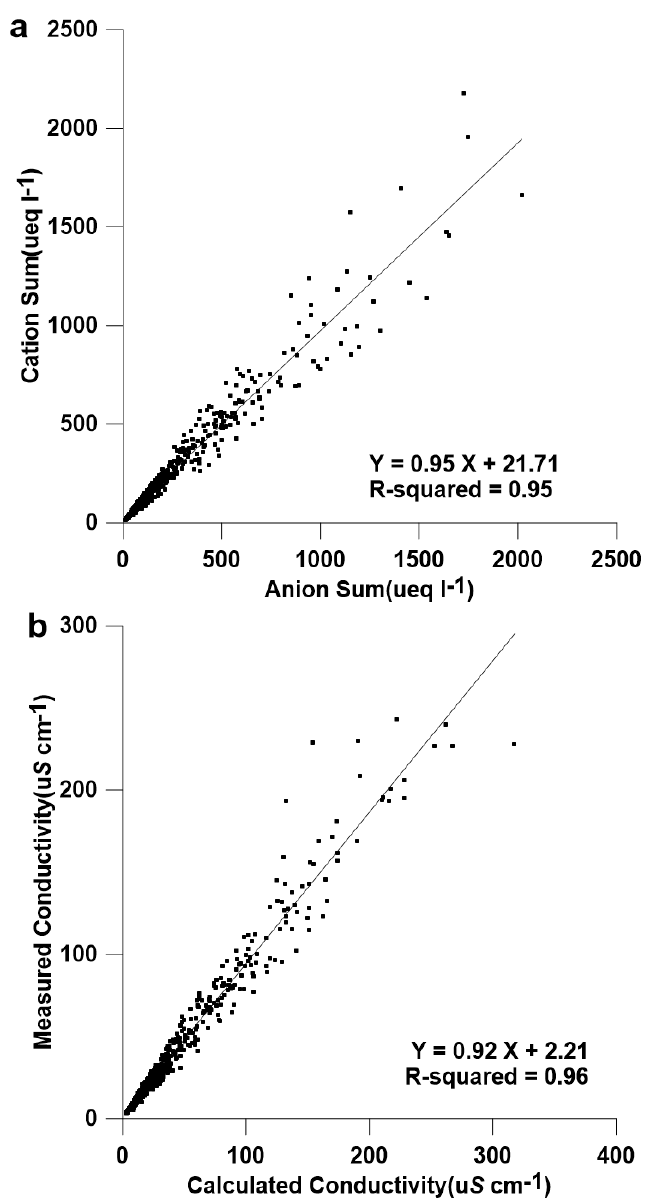
Figure 2. Linear regression ( a ) between the sum of cations and anions, and ( b ) between measured and calculated